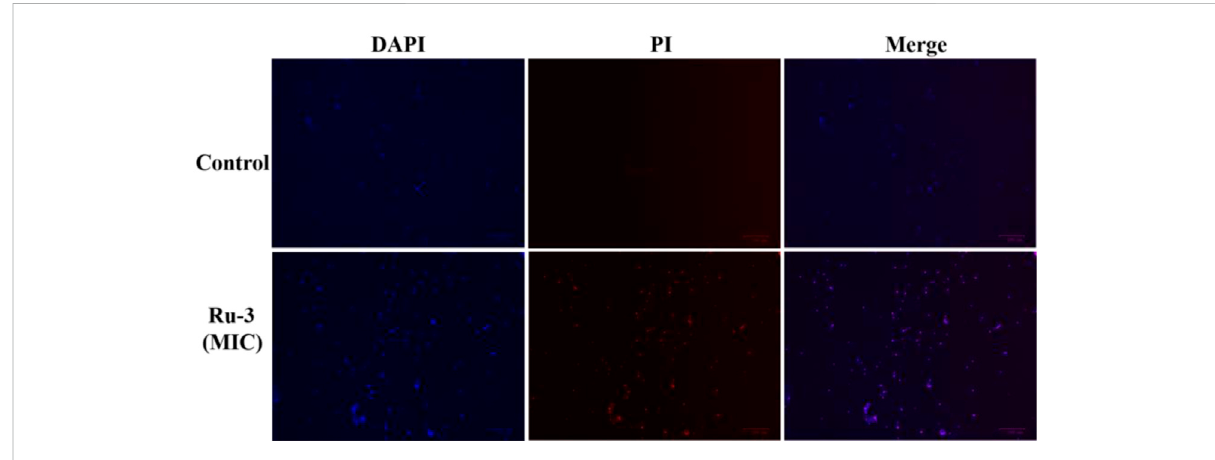
FIGURE 11 Fluorescenceimages of Staphylococcus aureus control ortreated with Ru-3(4 μ g ml − 1 )for 2 h, which stained with DAPI, PI.Scalebar: 100 μ m.